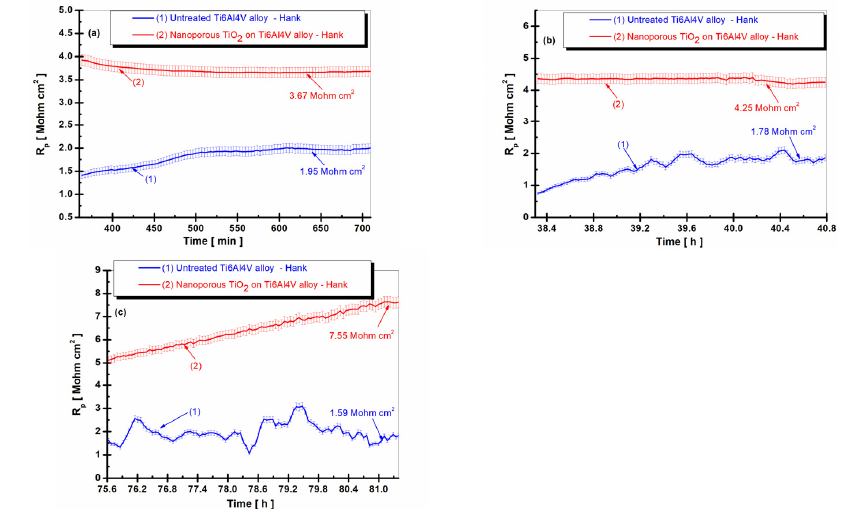
Figure 8. Comparative evolution of the polarization resistance during sample immersion in Hank’s biological solution: ( a ) after 6 h (360 min); ( b ) after 38 h (2298 min); and ( c ) after 75.5 h (4534 min). (1) untreated Ti6Al4V alloy and (2) the treated alloy with the electrochemically formed nanoporous TiO 2 film.